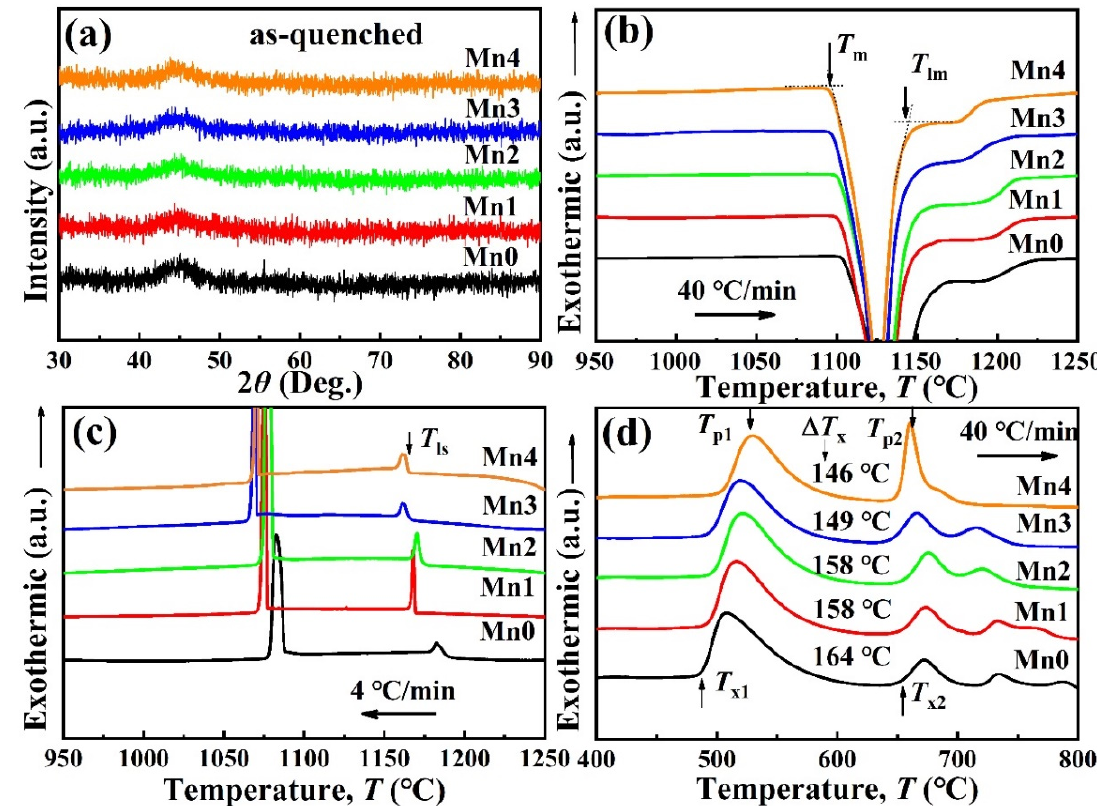
Figure 1. Thermal and structural characteristics of Mn0, Mn1, Mn2, Mn3, and Mn4. ( a ) XRD patterns of the as-quenched ribbons, showing a fully amorphous structure; DSC curves of the ( b ) heating and ( c ) cooling of master alloys, showing the melting and solidification processes; ( d ) DSC curves of the as-quenched ribbons, showing a large Δ T of 146 ~ 164 °C.